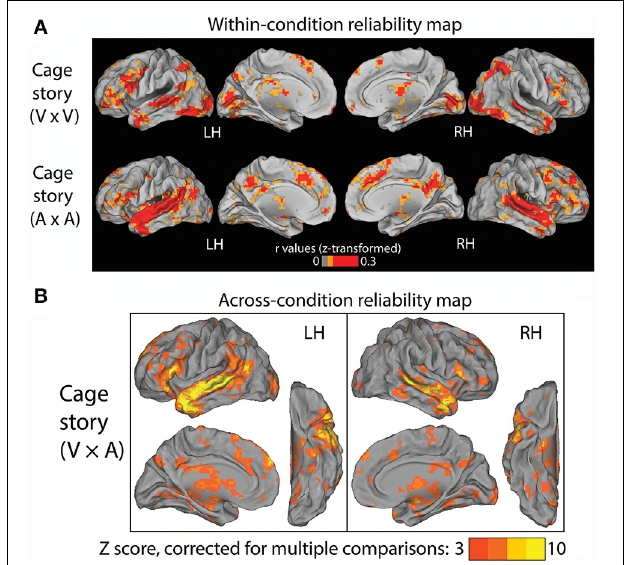
FIGURE 2 | Results of Experiment 1. (A) Within-condition reliability map. fMRI time series were correlated between subjects who read the “Cage” story (top row) and between those who listened to the “Cage” story (bottom row). The Pearson correlation coefficients were z-transformed and averaged across all subjects in each group ( N = 9). (B) Across-condition reliability map. fMRI time series were correlated between subjects who listened to the “Cage” story and those who read the same story (V × A, see Figure 1C , Experiment 1). The population-average z-transformed correlation values were compared to phase-shuffled data to determine the Z -score (thresholded at Z > 3, cluster size > 17 voxels, corresponding to p < 0 . 05 after correction for multiple